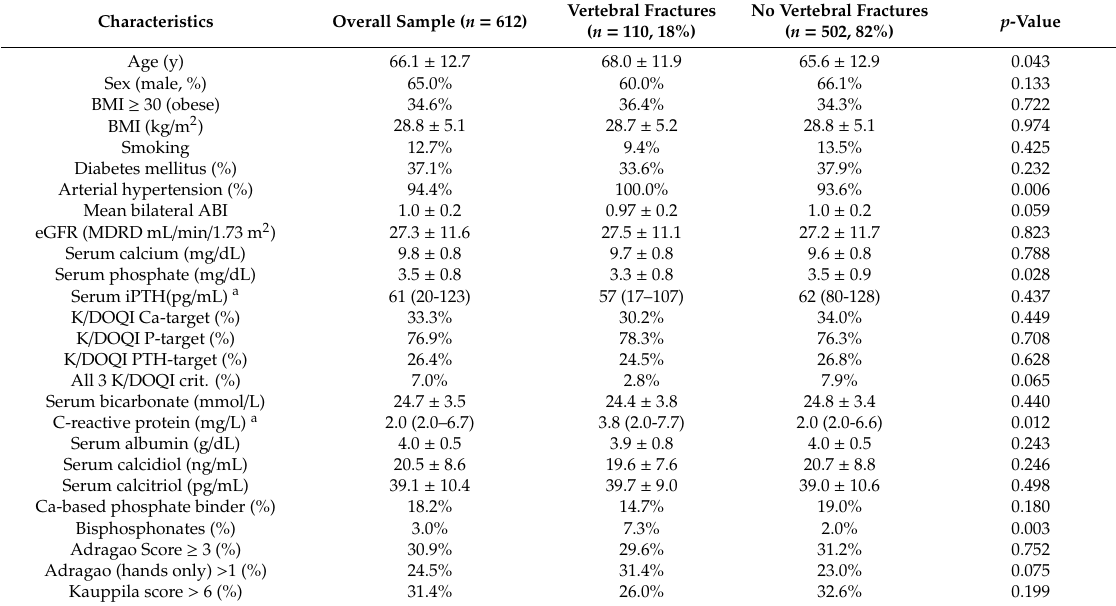
Table 1. Demographic and clinical characteristics of OSERCE 2 patients included.